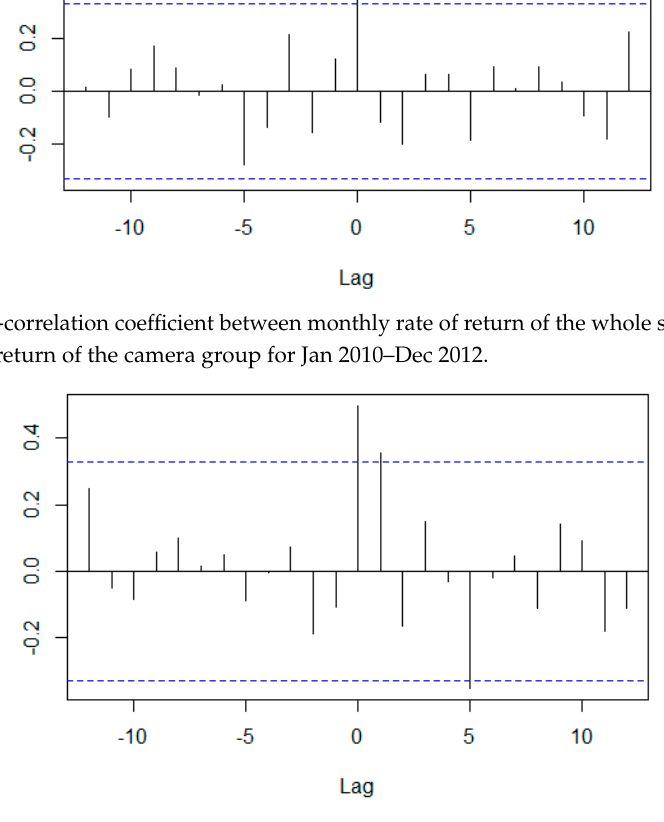
Figure 25. Cross-correlation coefficient between monthly rate of return of the camera group and monthly rate of return of the display group for Jan 2010–Dec 2012.